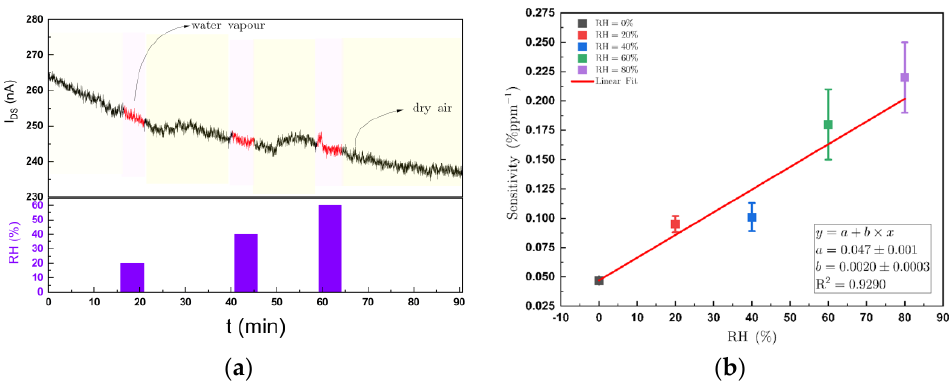
Figure 9. ( a ) Plot of I DS for an OFET device when exposed to different humidity levels. The baseline was in dry air, the lower panel illustrates when different changes in humidity were applied and the red portion of the I DS trace above highlights the current during this exposure; ( b ) the apparent increase in OFET sensitivity to ammonia with increasing relative humidity (RH). A series of concentrations of ammonia ranging from 20 to 100 ppm were presented to the OFET sensor while varying the RH from 0 to 80%. The I DS was measured at V GS of − 3 V and V DS of − 3 V. From the resulting concentration–response curves at each humidity step, the gradients of the curves were extracted and plotted here as sensitivity versus